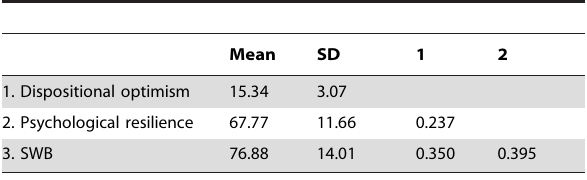
Table 1. Inter-correlations between dispositional optimism, psychological resilience and SWB.